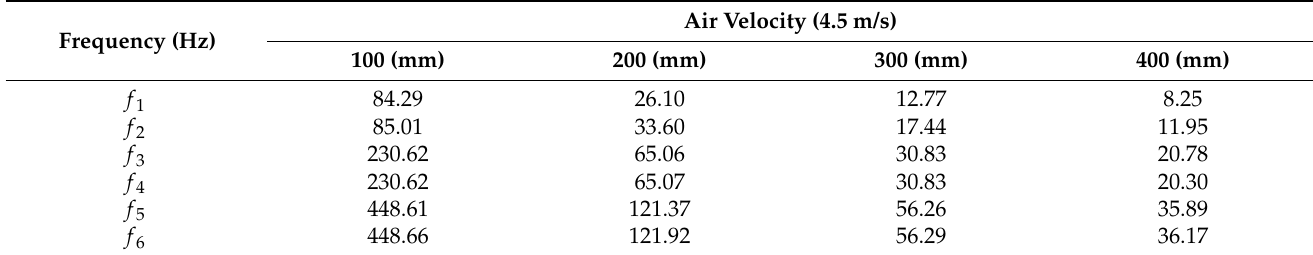
Table 6. The first 6-order natural frequencies with different fiber lengths at air velocity 4.5 m/s.